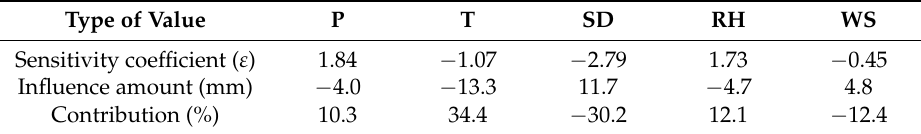
Table 5. Climate elasticity coefficient and contributions of climatic factors.